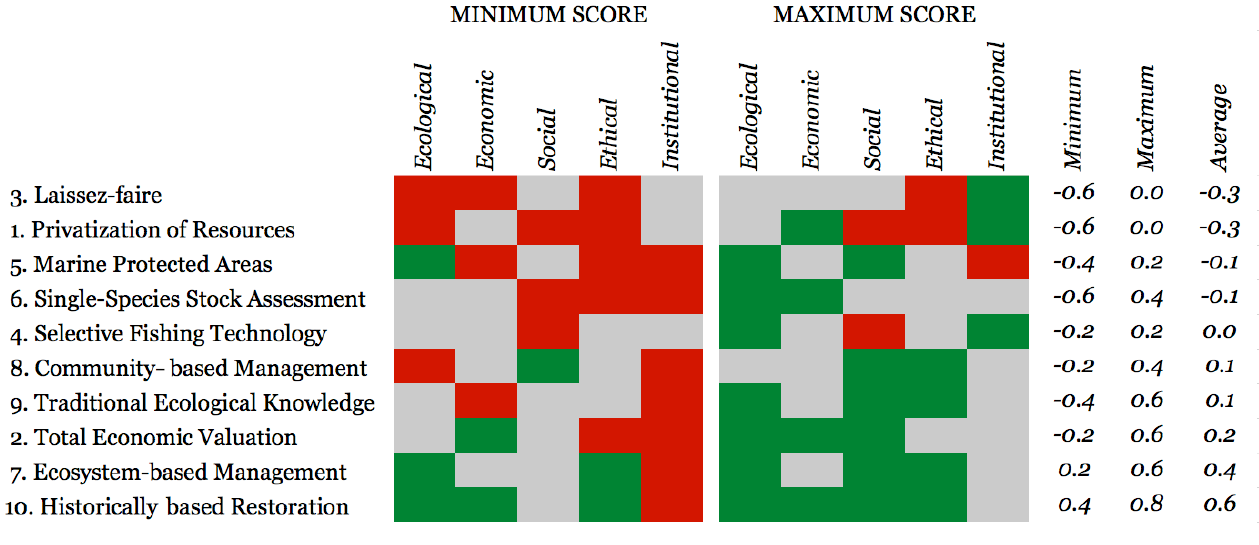
Fig. 3 . Composite policy performance ratings illustrating the trade-offs inherent in ten common fishery management strategies. The overall average performance of the management strategy rows increases from top to bottom; the numbers correspond to their order of discussion in the text. The pattern of scores, color-coded for positive (green, +1), neutral (grey, 0), and negative (red, -1) outcomes, provides a policy footprint for each strategy. Minimum and maximum scores were assigned by the authors for the weak ‘panacea’ and more nuanced descriptions, respectively, by synthesizing published accounts cited in the text and our individual experiences. The range between these scores expresses our estimate of the uncertainty in the strategy, while the average score is our best estimate for the performance of each management strategy, aggregated across all modalities. Columns correspond to assessments along five policy performance modalities: Ecological, Economic and Social scores are based on sustainability criteria that measure viability (Pitcher and Preikshot 2001); Ethical scores are informed by an interdisciplinary ethical analysis for fisheries (Pitcher and Power 2000; Coward et al. 2000); and Institutional scores relate to data and infrastructure required to implement an institutional framework (Ostrom 2005) capable of delivering this management